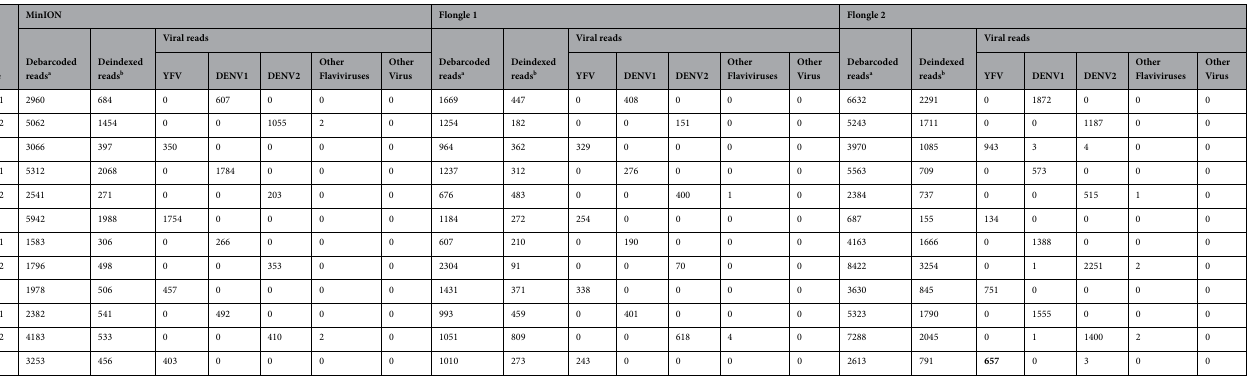
Table 1. Details of the reads obtained from validation of the system using spiked sample and the optimized pipeline. Viral RNA was extracted from fetal bovine serum spiked with 10 5 PFU/mL DENV1, 10 4 PFU/mL DENV2, and 10 5 PFU/mL YFV17D, then subjected to RT-PCR and sequencing. The number of reads shown in the table were obtained the optimized pipeline data was analysed according to the pipeline shown in the Supplementary Fig. 1 a Reads survived after the debarcoded step is referred to debarcoded reads. b While reads passing the deindexing step will be referred as deindexed reads.